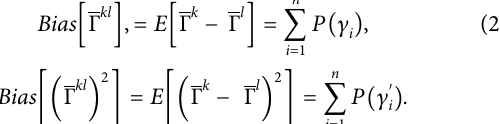
Frontiers in Physics |